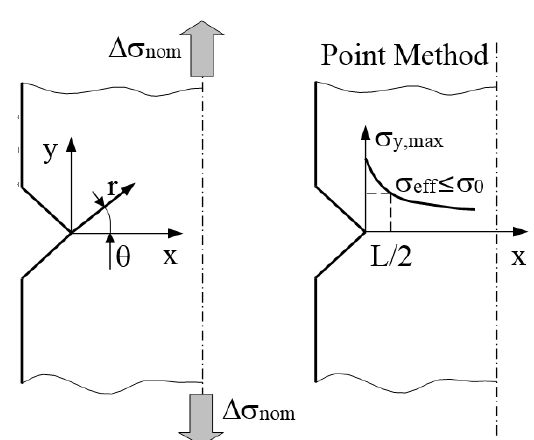
Figure 2: Effective stress,  eff , determined according to the